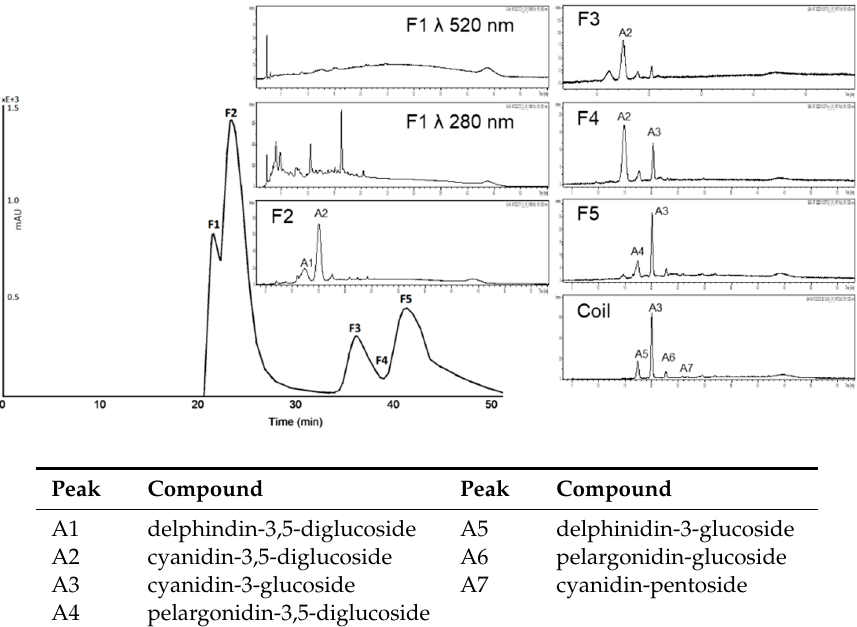
Figure 10. HPCCC chromatogram of AF of pomegranate NFC at a wavelength of λ 520 nm of P-AF and HPLC-ESI-MS/MS chromatograms of the composition of each fraction.